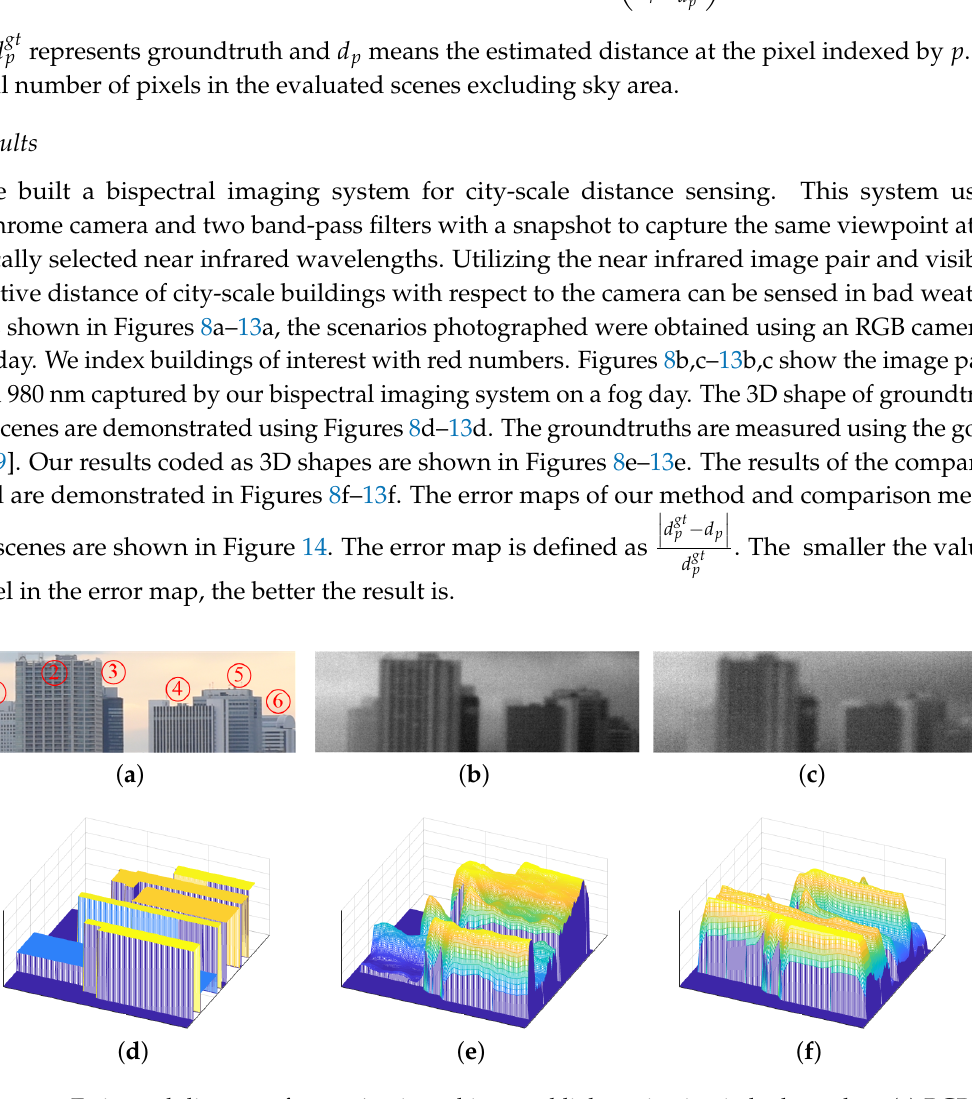
Figure 8. Estimated distance of scene 1 using a bispectral light extinction in bad weather. ( a ) RGB image. ( b ) Image at 905 nm. ( c ) Image at 980 nm. ( d ) Groundtruth. ( e ) Our result. ( f ) Result of comparison method.